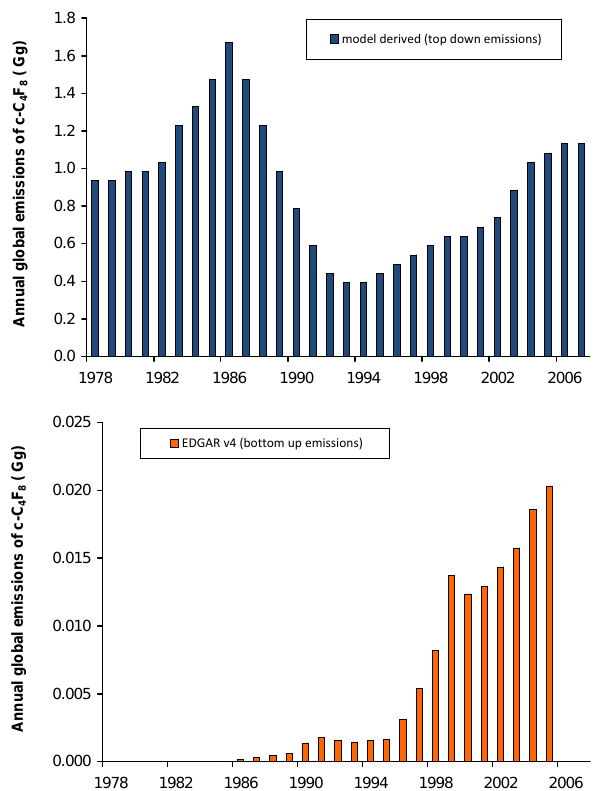
Fig. 2. Annual global emission estimates for c-C 4 F 8 derived from a 2-D model fit to the Cape Grim measurements (upper panel) and from the EDGAR v4.1 database (lower